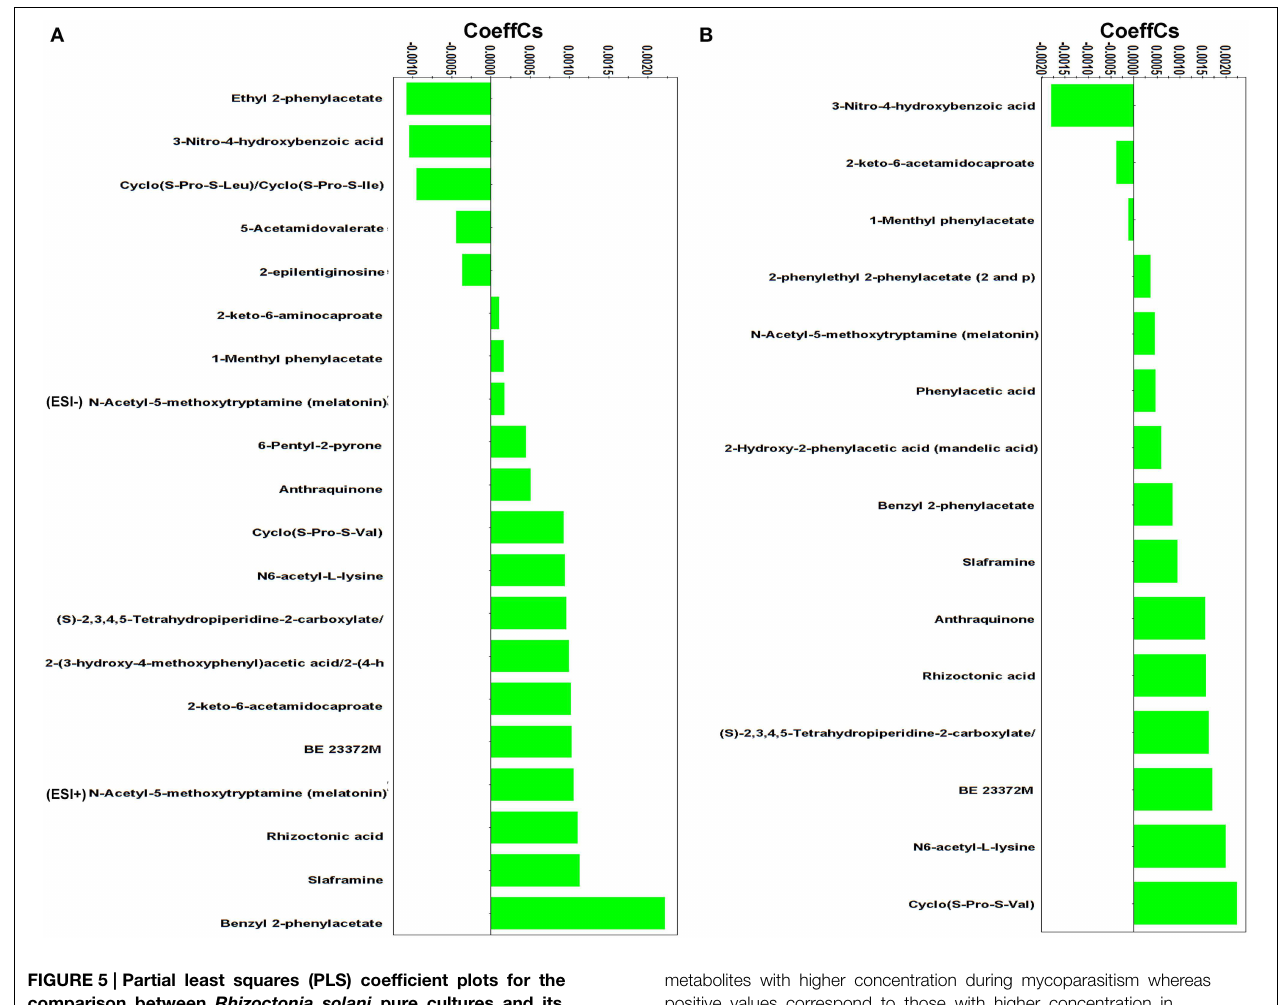
FIGURE 5 | Partial least squares (PLS) coefficient plots for the comparison between Rhizoctonia solani pure cultures and its dual-cultures with Stachybotrys elegans at D4 (A) and D5 (B) days with values of scaled and centered PLS regression coefficients (CoeffCS). Negative values of coefficients denote